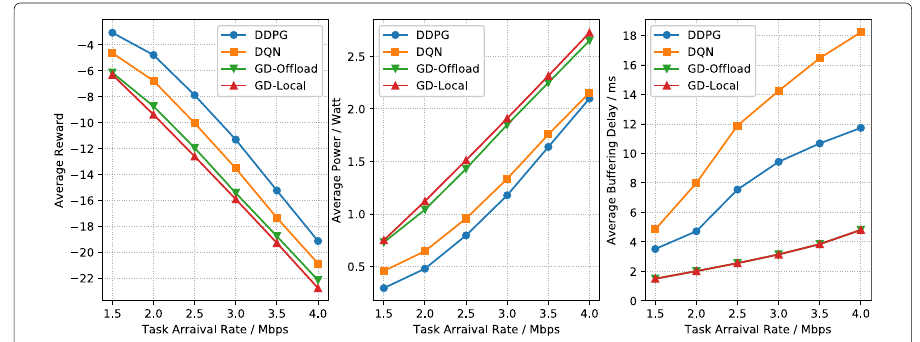
Fig. 7 Comparison of testing results for a single user agent with w 1 = 0.8